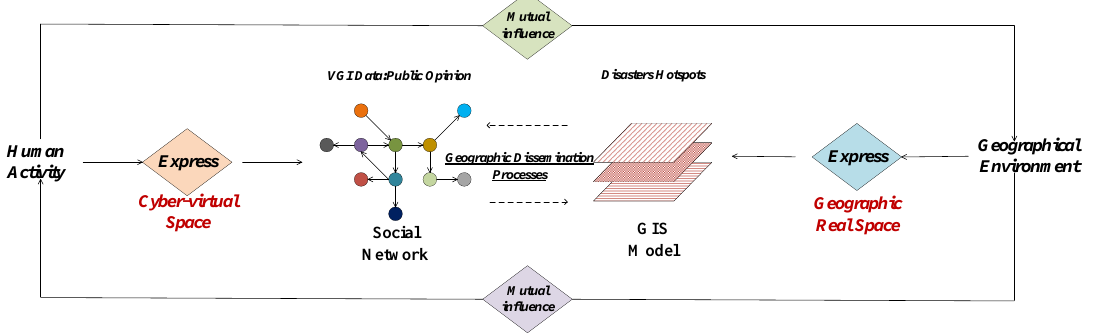
Figure 1. The coupling effect of cyberspace and